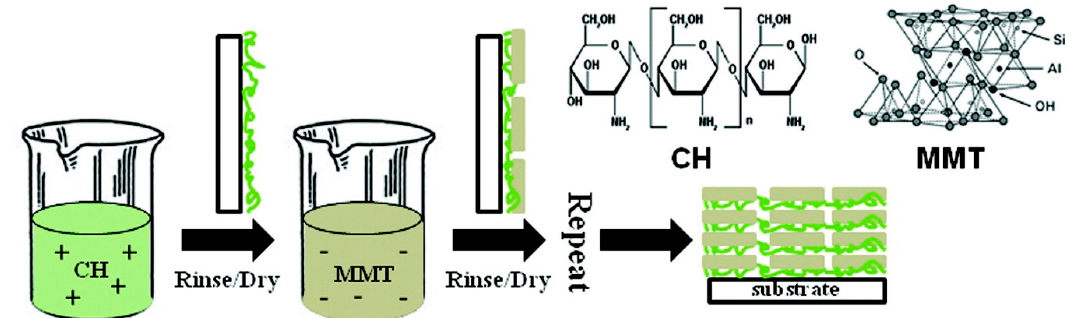
Figure 24. Schematic representation of Layer-by-Layer (LbL) assembly with chitosan (CH) and sodium montmorillonite clay (MMT). This process is repeated until the desired number of bilayers is deposited. Reprinted with permission from [53]. Copyright 2012, American Chemical Society.